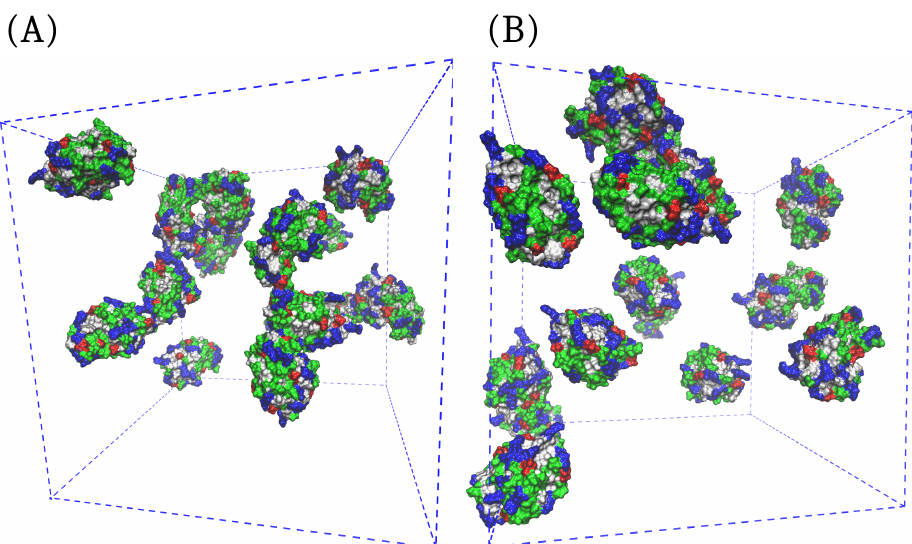
Figure 4. Snapshots from the computer simulations showing just HEWL molecules ( A ) without the presence of free arginine and ( B ) with added 0.3 M arginine.